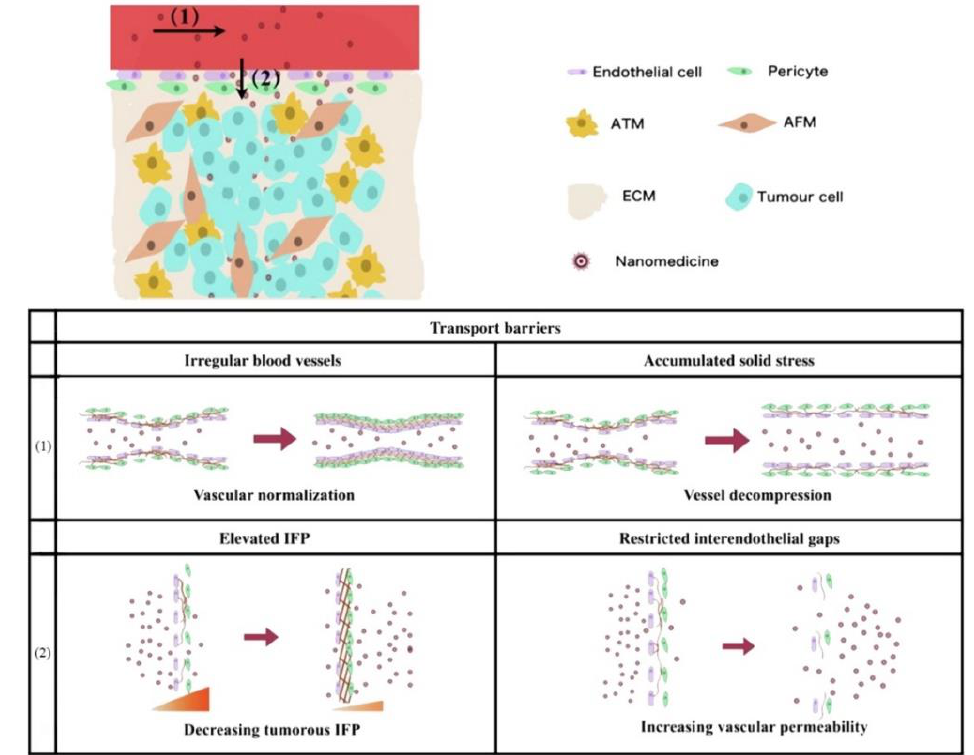
Figure 2. Schematic representation of vascular-related problems and countermeasures faced in the process of nanodrug penetration. (1) Intravascular transport: vascular irregularity and cumulative solid stress are resolved by normalization and decompression, respectively. (2) Trans-vascular transport: elevated interstitial fluid pressure (IFP) and limited endothelial space are improved by decreasing intertumoral IFP and increasing vascular permeability, respectively. Adapted from Yang et al. [115] .